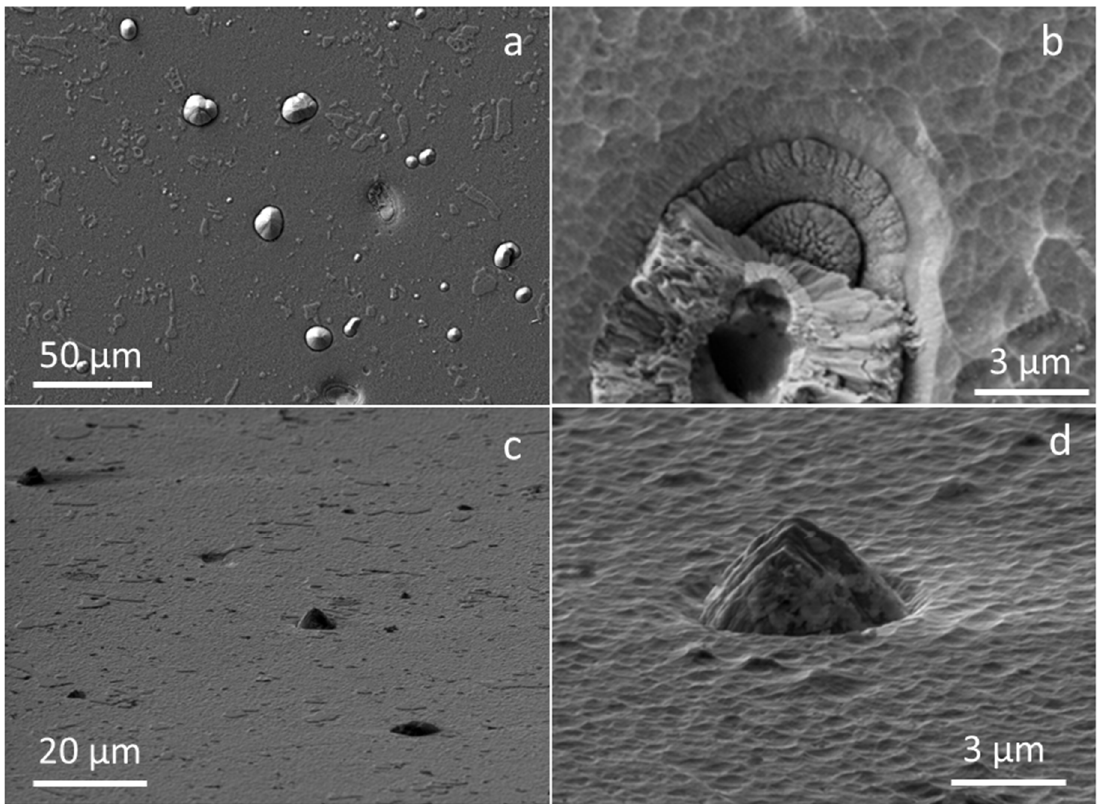
Figure 1. Plan-view SEM images of as-deposited TiAlN hard coating deposited onto D2 tool steel substrate. SEM images were recorded at low ( a , c ) and high ( b , d ) magnifications, while the images on the bottom ( c , d ) were taken by tilting the sample by approximately 20°.